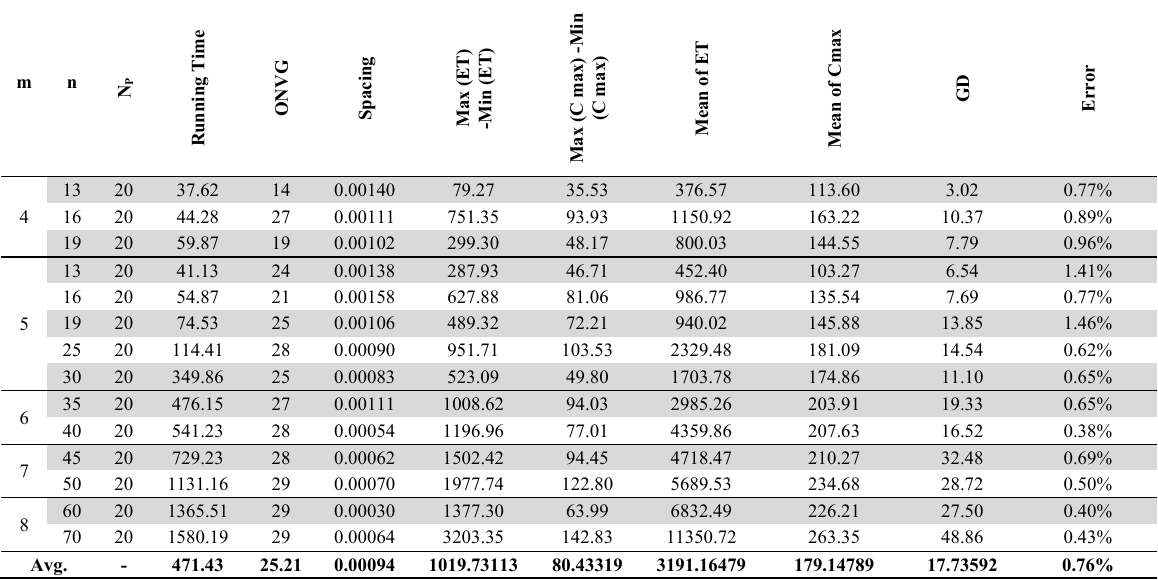
The results of solving medium and large size